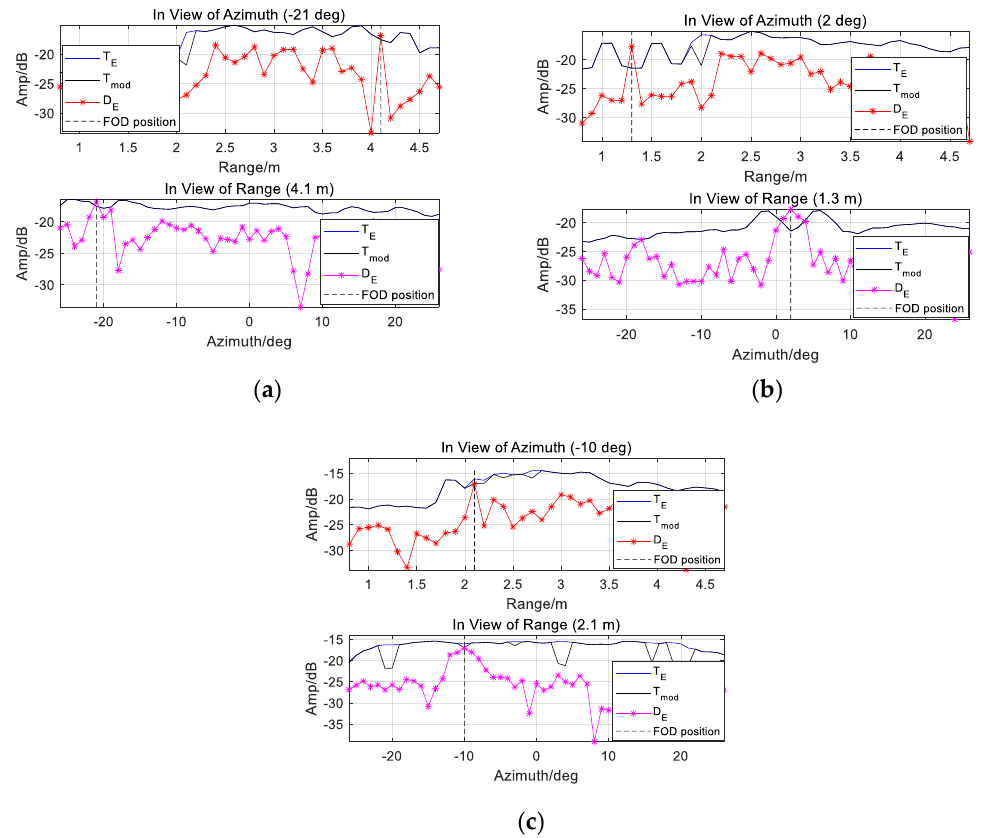
Figure 14. The results of CA-CM-CFAR detector are shown in view of range and azimuth, aiming at ( a ) Target 1; ( b ) Target 3; ( c ) Target 5, by employing T E and T mod respectively. • Experiment 3